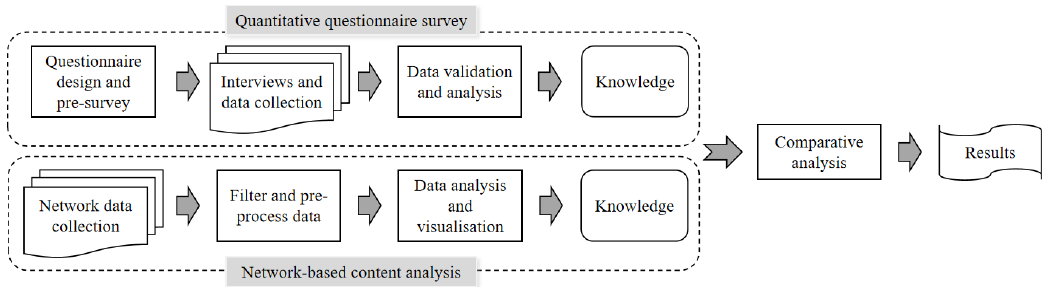
Figure 2. A two-staged, mixed research process